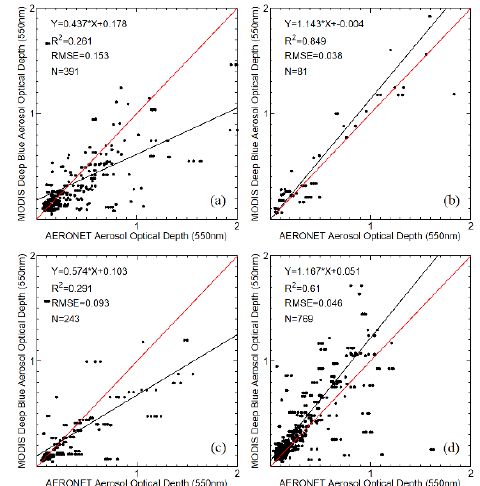
Figure 1. Scatter plots of MODIS AODs versus AERONET AODs in Beijing The black and red lines represent the slopes of linear regression and the 1:1 lines of scatter plots.